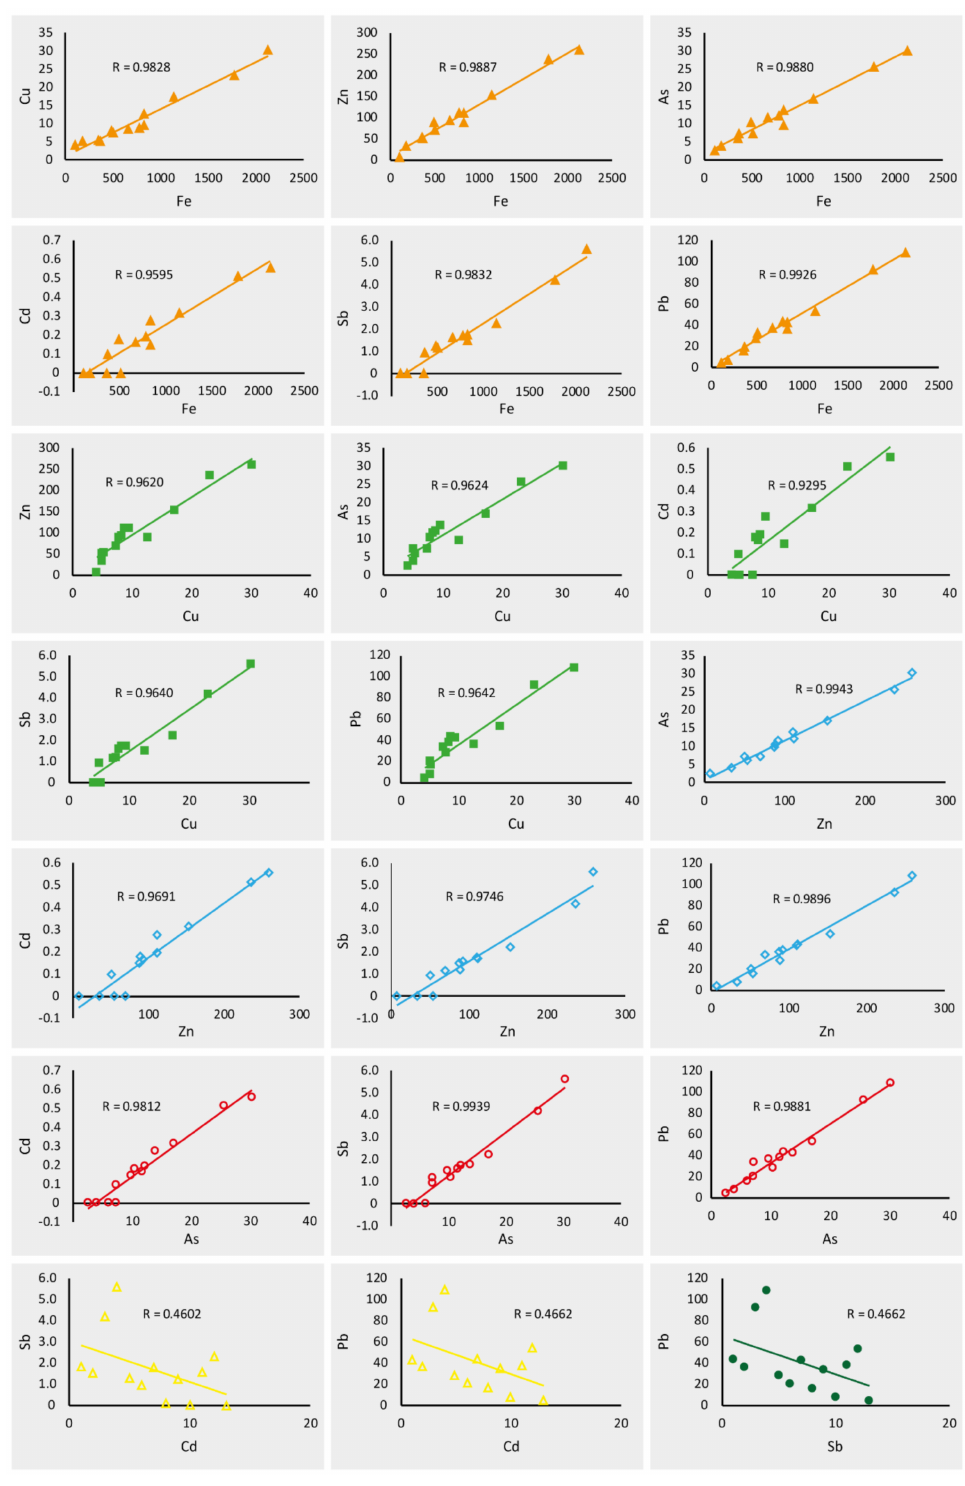
Figure 8. Representation of the chemical elements with significant